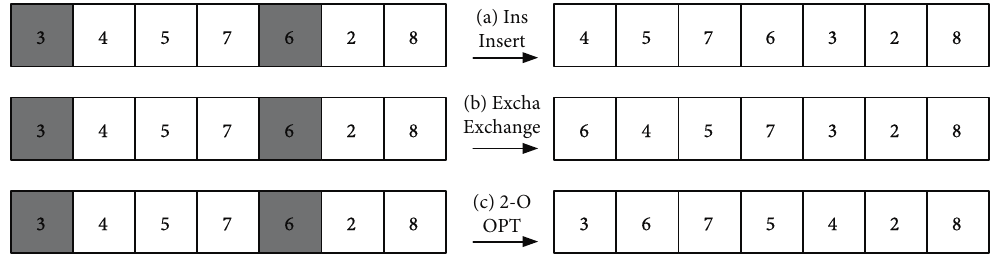
Figure 11: Neighborhood structures. (a) Insert. (b) Exchange. (c)